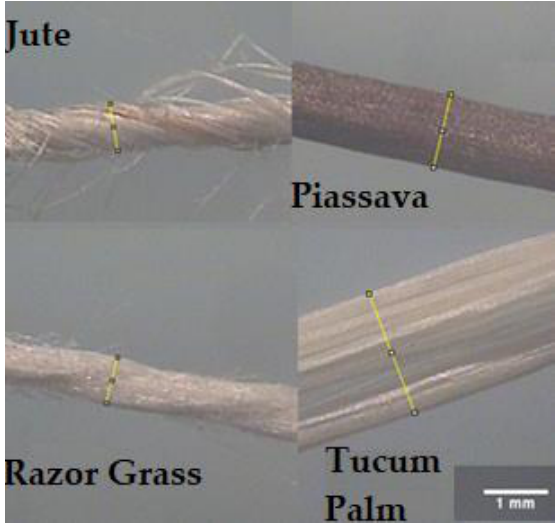
Figure 1. Image of untreated fibers. Fibers: Jute (from the stems of the plants), Piassava (from the stems of the plants), Razor Grass (from the leaves of the plants) and Tucum Palm (from the leaves of the plants). (All images with 20× enlargement photos).